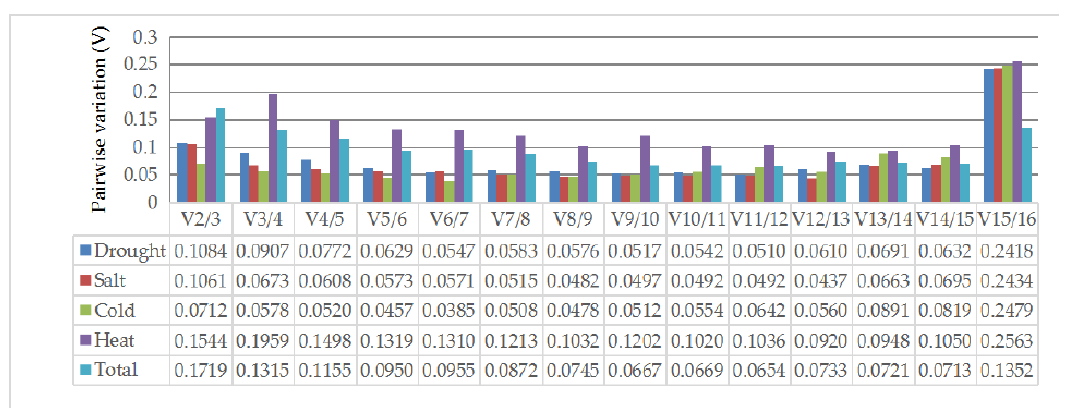
Figure 3. Pairwise variation (Vn / Vn + 1) values calculated by geNorm for samples from drought, salt, cold, and heat stress, and for the combination of all samples. The threshold value to determine the optimal number of RGs for qRT-PCR normalization is 0.15. Table 4. Gene expression stability in L. olgensis . under multiple stress treatments, as ranked by the software program